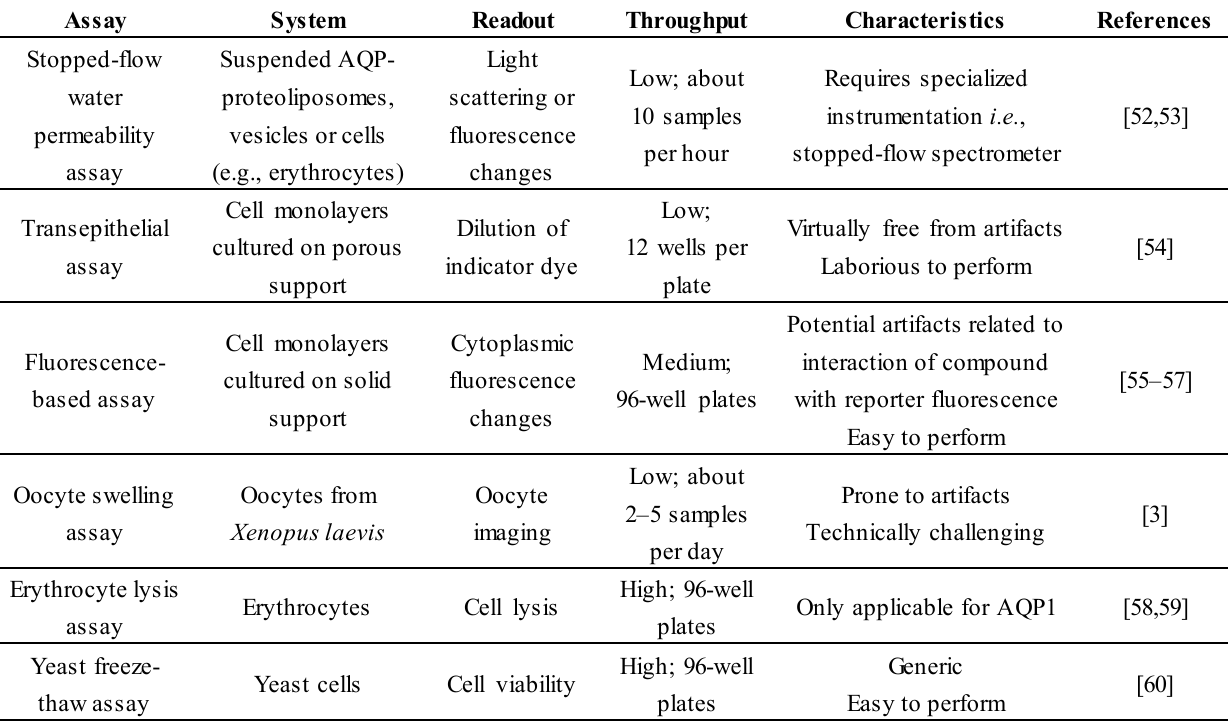
Table 1. Currently known aquaporins (AQP) water transport functional